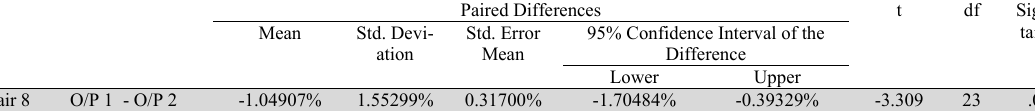
Paired Differences